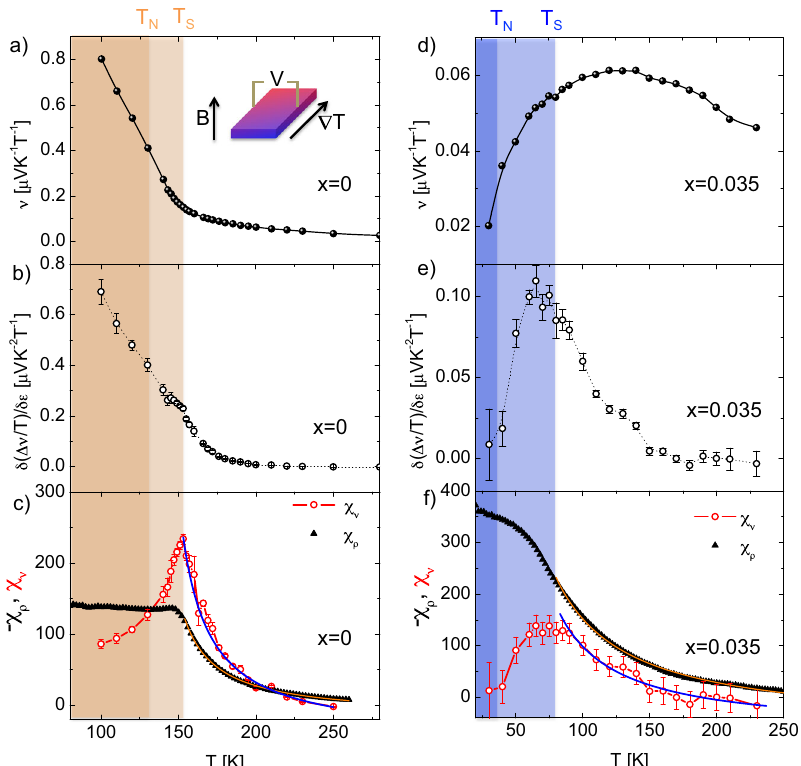
Fig. 3 Elasto-Nernst effect of the LaFe 1 − x Co x AsO compounds with x = 0 and x = 0.035. a Temperature dependence of the Nernst coef fi cient ν of the x = 0 compound. b Temperature dependence of the strain derivative of the T -normalized Nernst coef fi cient δ ( Δ ν / T )/ δ ϵ x = 0 compound. c Temperature dependence of χ ν (red circles with red line) and - χ ρ (black triangles) of the x = 0 compound. d Temperature dependence of the Nernst coef fi cient ν of the x = 0.035 compound. e Temperature dependence of the strain derivative of the T -normalized Nernst coef fi cient δ ( Δ ν / T )/ δ ϵ x = 0.035 compound. f Temperature dependence of χ ν (red circles with red line) and − χ ρ (black triangles) of the x = 0.035 compound. The blue (orange) solid lines in fi g. c , f ) represent the Curie – Weiss fi t for T > T S of χ ν ( − χ ρ ). The dark-orange and the dark-blue areas indicate the regions where the long range structural and magnetic ordered states are both established. The error-bars represent the standard